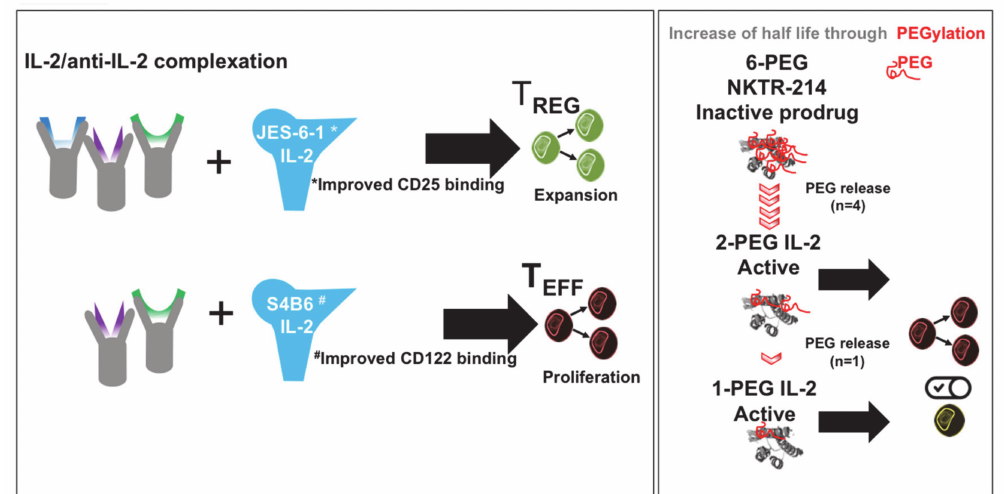
Figure 3. IL-2 modification for cellular targeting and prolonged half-life. IL-2 complexation with monoclonal antibodies (named JES-6-1 and S4B6) improves binding to either CD25 (JES-6-1 / IL-2 complex) or CD122 (S4B6 / IL-2 complex). This allows researchers to expand Treg numbers by JES-6-1 / IL-2 complexes and increase proliferation of e ff ector T cells by S4B6 / IL-2 complexes. PEGylation of IL-2 forms 6-PEG IL-2, which is inactive and upon release of 4 PEG becomes activated. Further release of 1 PEG increases the half-life of active 1-PEG IL-2 in the